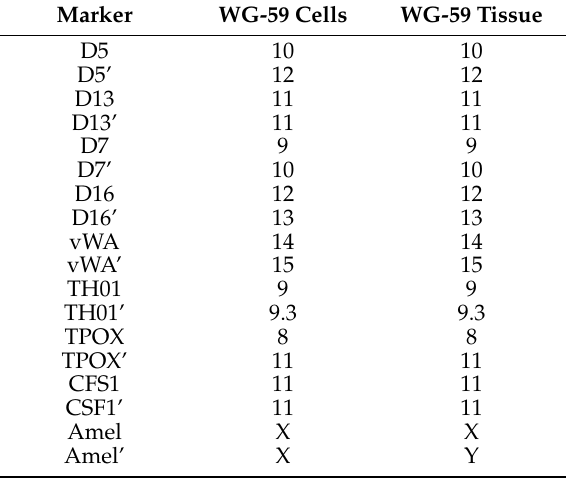
Table 2. Allelic list of the WG-59 cell line and tissue donor STR loci profiling using 8 different polymorph loci, performed by DSMZ, Germany, showing that these two samples are of the same origin.